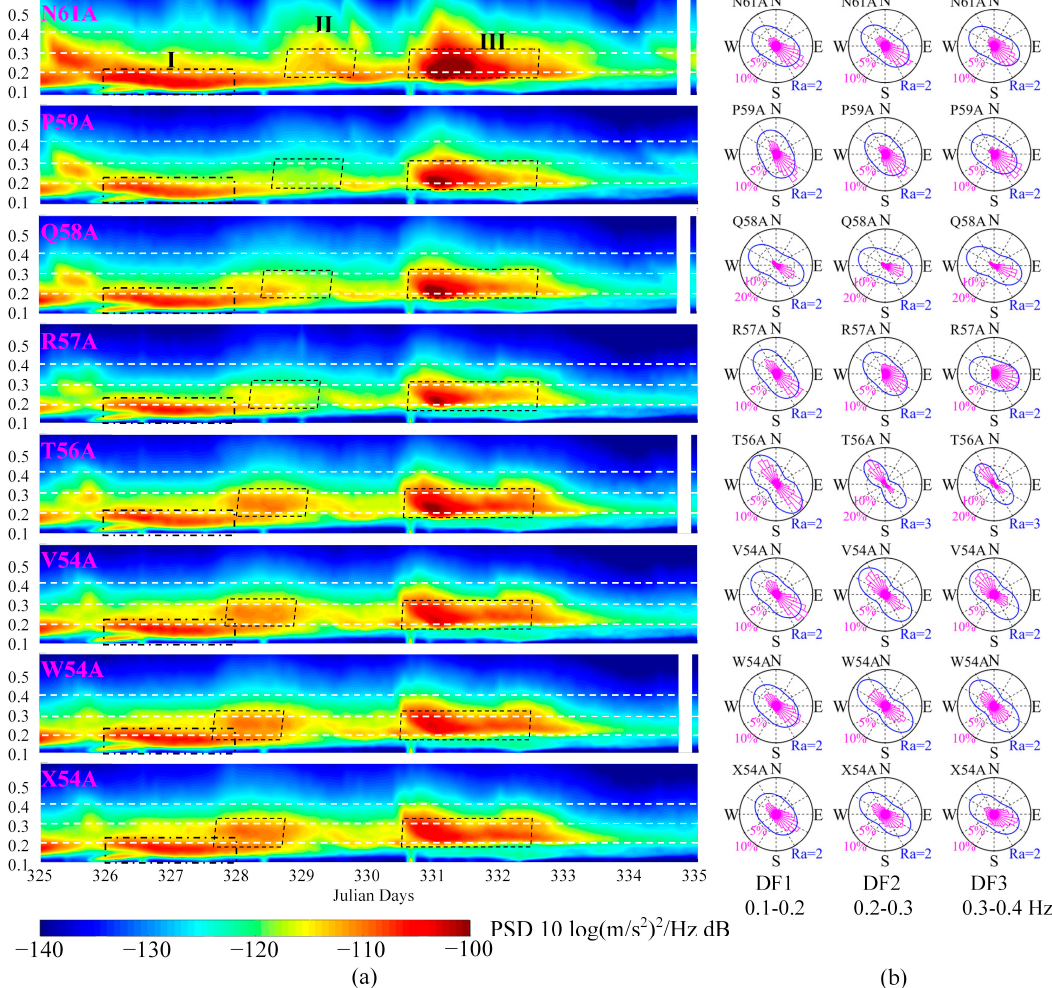
Figure 2. ( a ) Power spectral density (PSD) plots in time-frequency domain of the vertical components at the selected stations. The dashed lines at 0.2 and 0.3 Hz mark the boundaries of the three frequencies ranges. Three relatively strong double-frequency (DF) microseism events are identified and labeled as I, II, and III. ( b ) Polar plots of average Ra ( ϕ ) values (blue) combined with rose diagrams of back azimuths (calculated by the polarization analysis) (purple) at the three DF bands at the selected stations in the whole recording period. On each plot, the text labels refer to the recording station (e.g., N61A), probability of back azimuth (in purple, e.g., 10%) and the scale of the solid outer circle in multiples of the Ra ( ϕ ) value (in blue, e.g., Ra = 2). The same plots for the remaining stations are shown in Figure